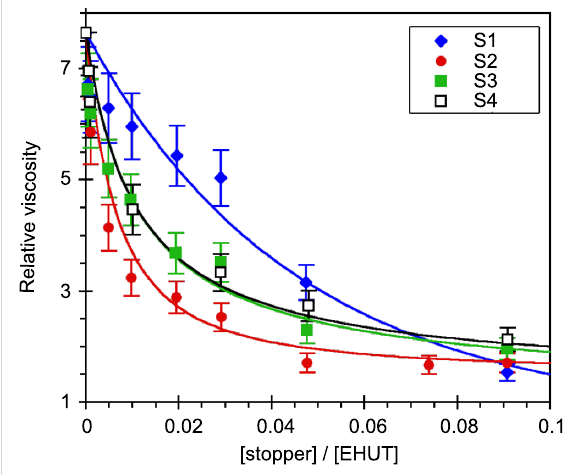
Figure 5: Relative viscosity for solutions of EHUT (20 mM) in 1,3,5- trimethylbenzene at 25 °C, with increasing molar fraction of chain stop- pers. The lines are a guide for the eye only.